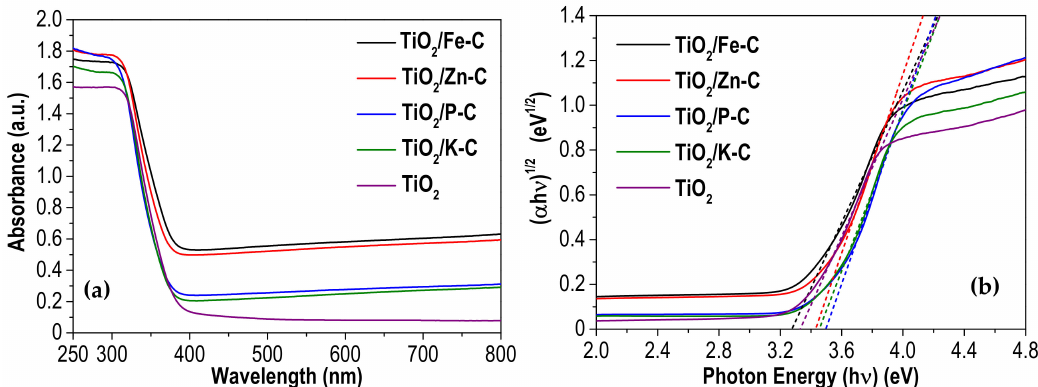
Figure 5. ( a ) UV–vis diffuse absorbance spectra and ( b ) the ( α h υ ) 1/2 versus (h υ ) plot of the synthesized